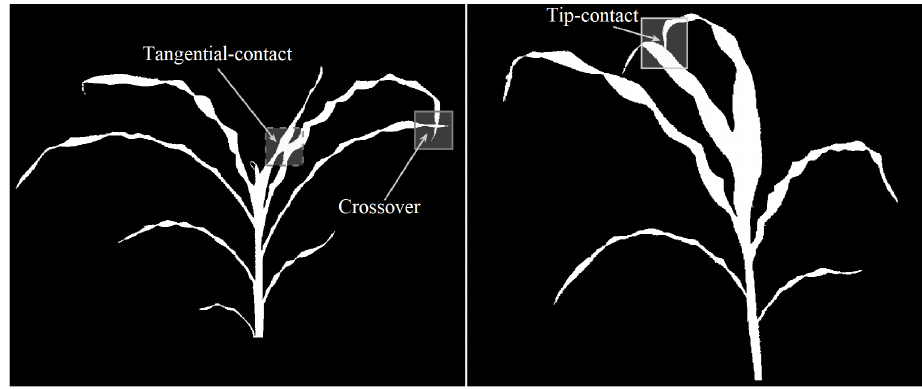
Figure 9. Illustration of types of leaf intersections: tip-contact, tangential-contact, and crossover. The proposed algorithm tracks each leaf starting from its junction, using a bottom-up approach, by following the edge until it reaches a tip (degree one node). When there is no leaf intersection, only degree two nodes are encountered along the way. In the presence of leaf intersections, the algorithm encounters higher degree nodes and must select the edge that represents the continuation of the current leaf. A look-ahead approach is used to determine the next node in the path, i.e., we select the node that provides the highest continuity, measured by angular consistency, with the leaf segment traced so